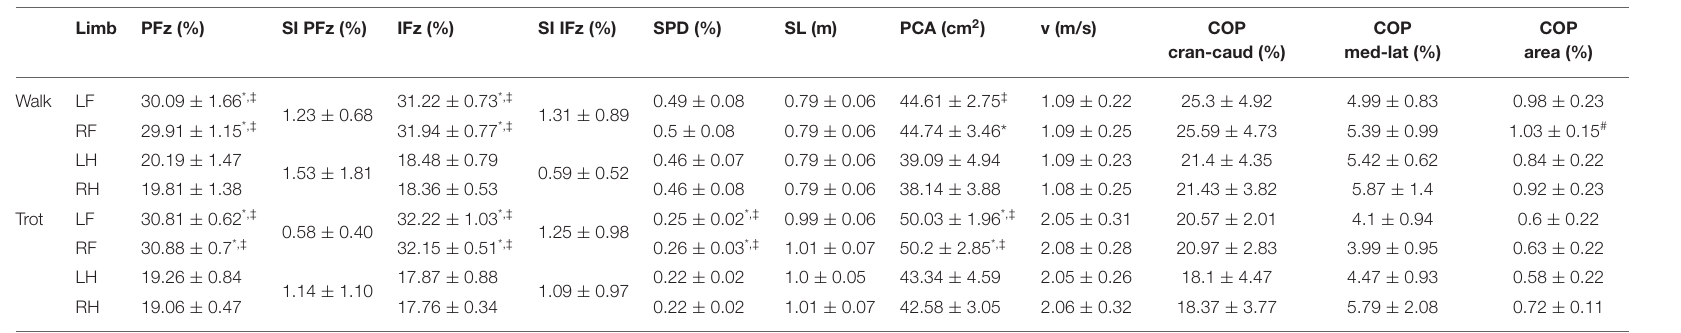
TABLE 3 | Mean ± standard deviation of all parameters for the condition “boots on both front limbs.”